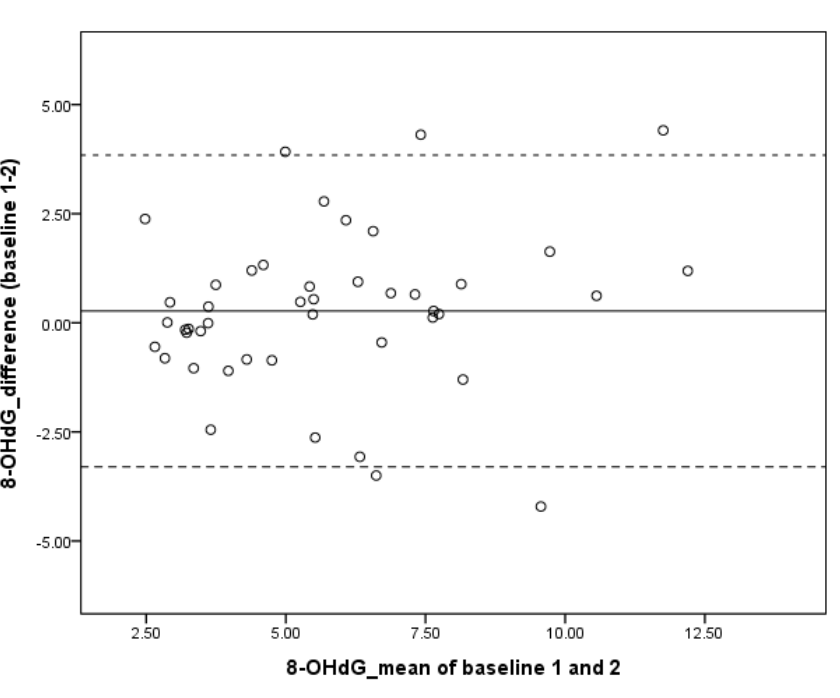
Figure 1. The Bland-Altman plot shows the test-retest reliability of urinary 8-hydroxy-2'- deoxyguanosine (8-OHdG) levels. The reference lines show the mean differences between baseline 1 and baseline 2 assessments of 8-OHdG (solid line: 0.27), and the 95% limits of agreement for the mean difference (dotted lines: − 3.30 and